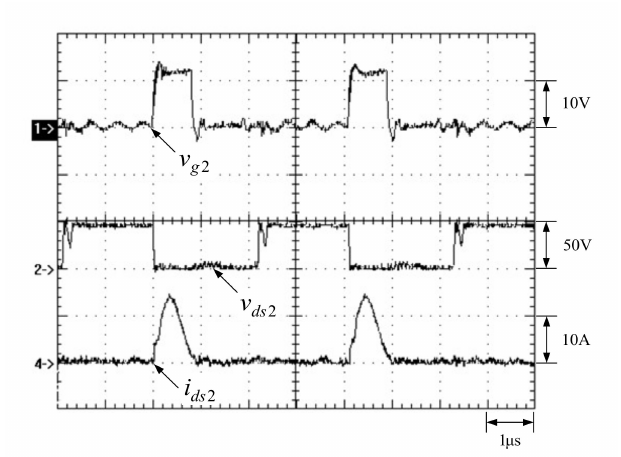
Figure 15. Waveforms relevant to S 2 : (1) v g 2 ; (2) v ds 2 ; (3) i ds 2 .